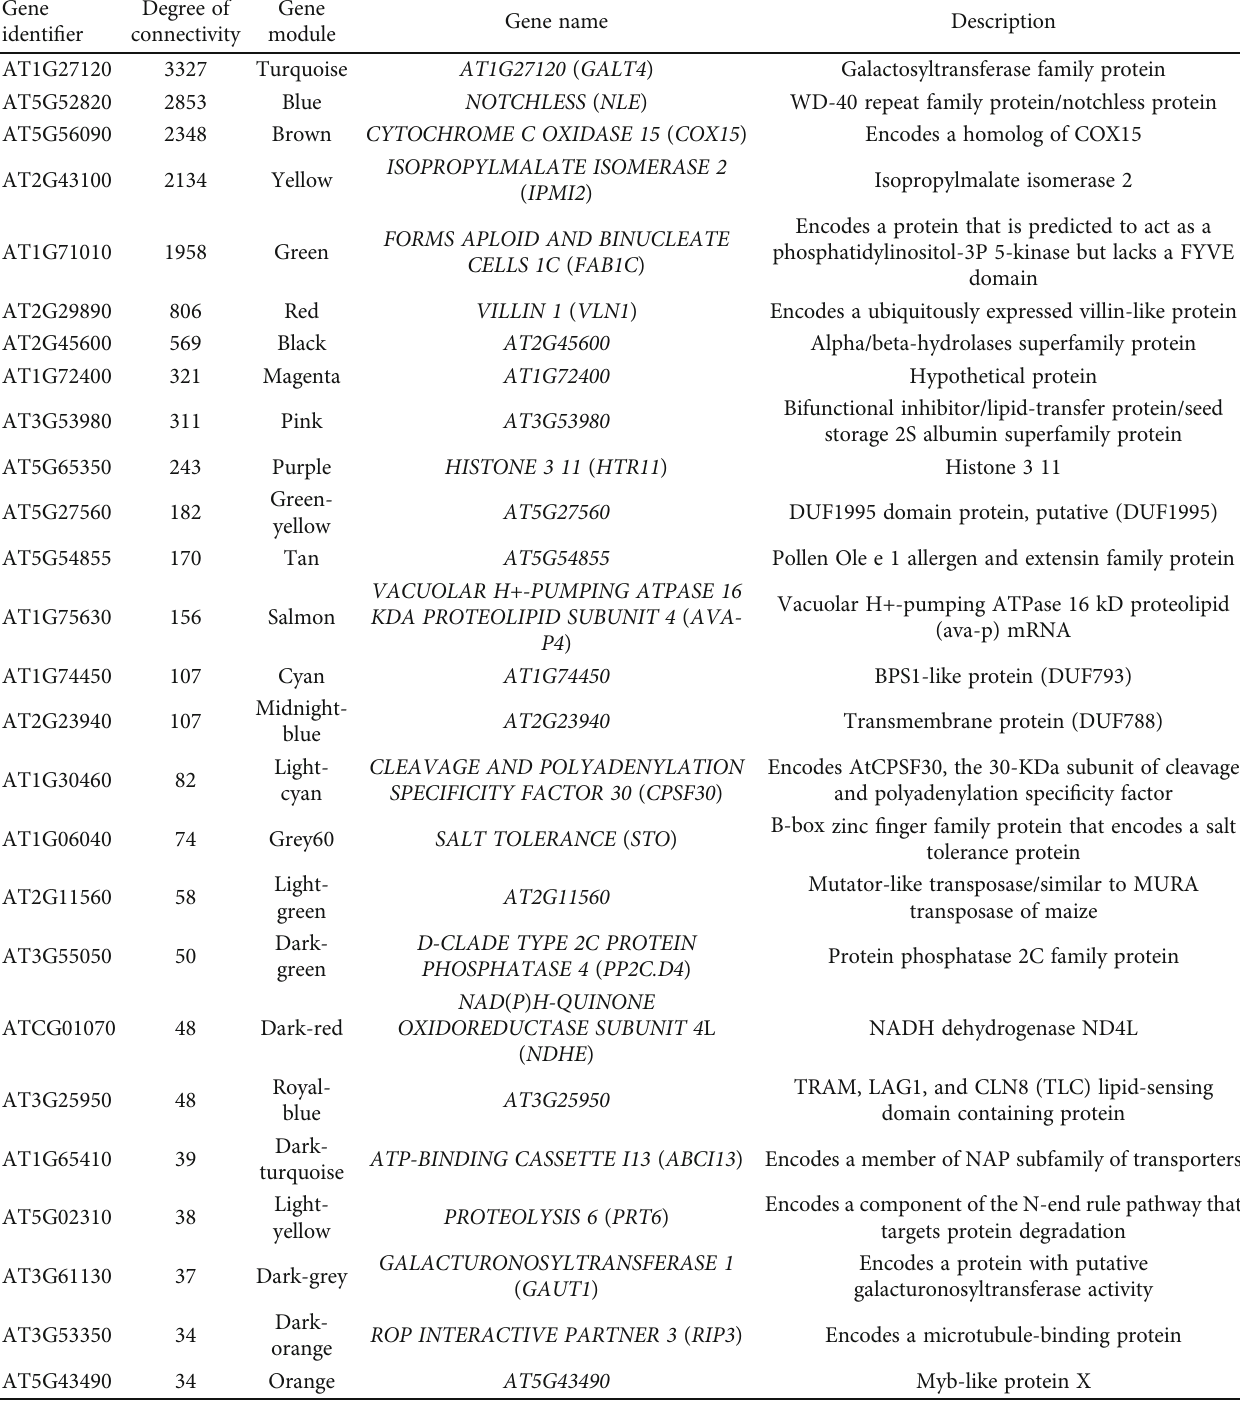
Table 1: Top 10 hub genes ordered by the degree of